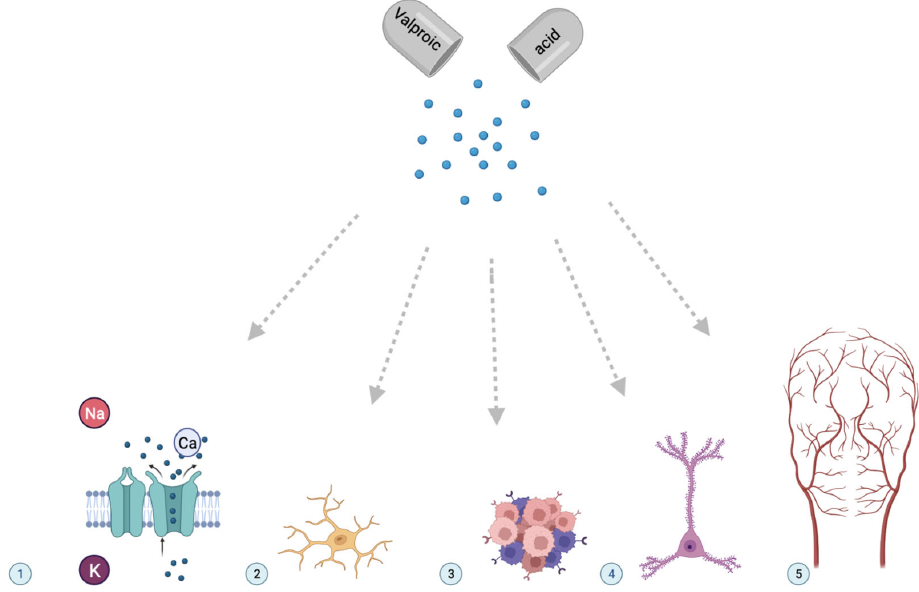
Figure 3. The most common clinical therapeutic effects of valproic acid metabolites. Notes: (1) blockade of voltage-dependent sodium, calcium, and potassium channels; (2) neuroprotection; (3) inhibition of signaling pathways in cancer cells; (4) modulation of neurogenesis; (5) angioprotection. The most studied therapeutic metabolites of VPA in the blood and urine are presented in Tables 1 and 2. Table 1. Serum and Plasma Therapeutic Metabolites of Valproic Acid.